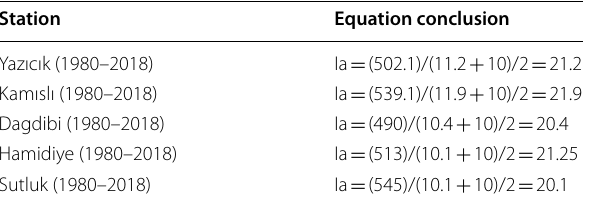
Table 9 Climate characteristics based on De Martonne classification Station